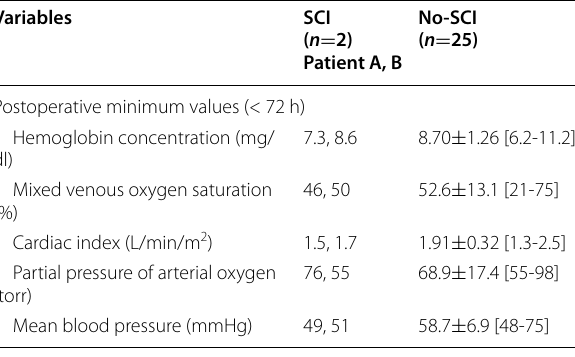
27) Table 3 Minimum values of hemoglobin concentration and = hemodynamic data within 72 h after surgery